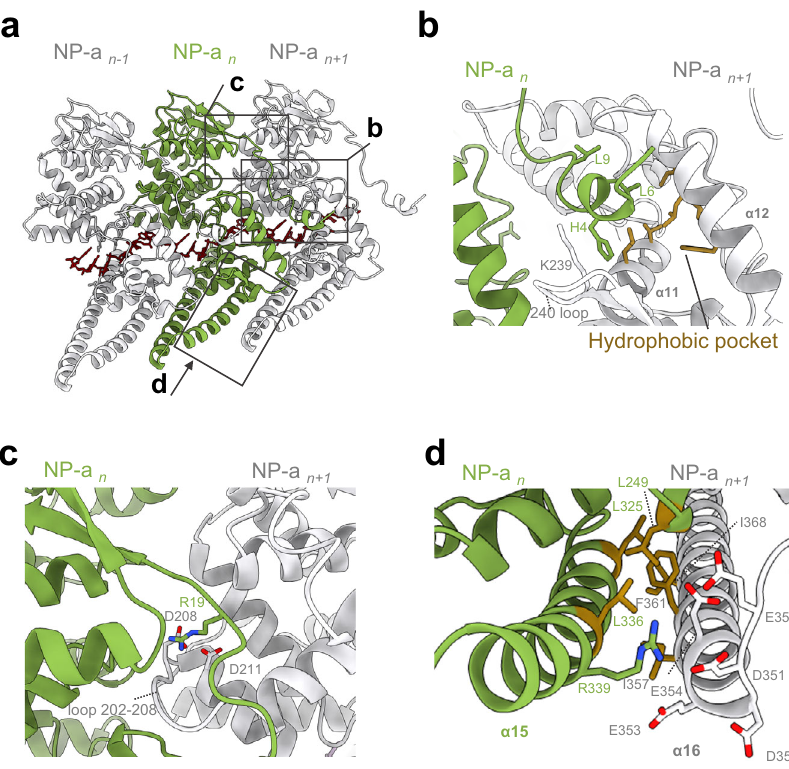
Fig. 3 NP – NP interactions. a Three adjacent NP molecules viewed from inside the helix. Black boxes show respective close-up fi gures. b NP – NP interactions between the N-terminal arm of NP n (green) and the hydrophobic pocket of an adjacent NP n + 1 (white, hydrophobic residues are shown in orange). c NP – NP interaction between the N-terminal lobe of NP n (green) and an adjacent N-terminal lobe of NP n + 1 (white). Basic residues are colored in blue, and acidic residues are colored in red. d NP – NP interaction between two C-terminal lobe helices in NP-a. Hydrophobic residues are shown in orange. Basic residues are colored in blue, and acidic residues are colored in